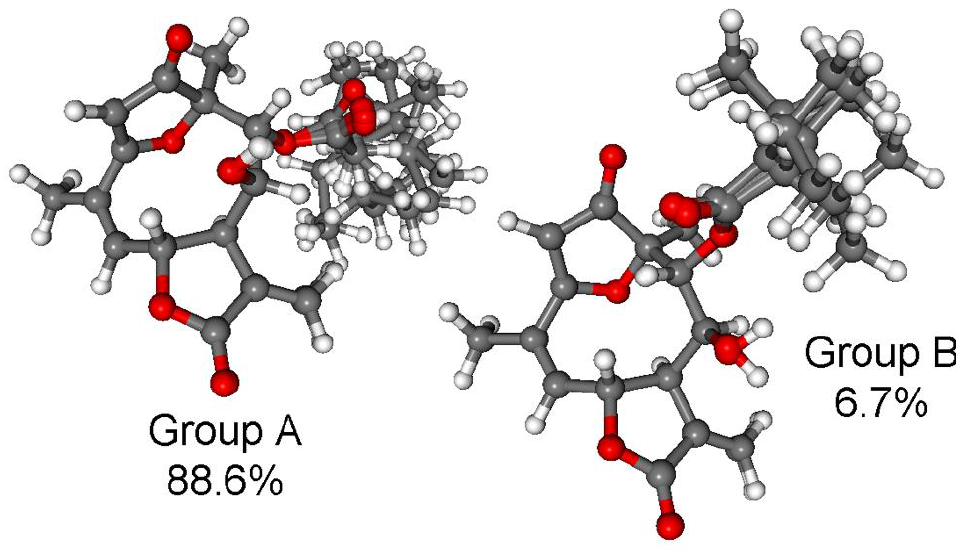
Figure 6. Overlapped geometries of the conformers of the two conformer groups of (6 R ,7 R ,8 S ,9 R ,10 R )- 3 . Group A: Confs. A-F, I, J; group B: Confs. G, H, K-M. Level of optimization: CAM-B3LYP/TZVP PCM/MeCN.